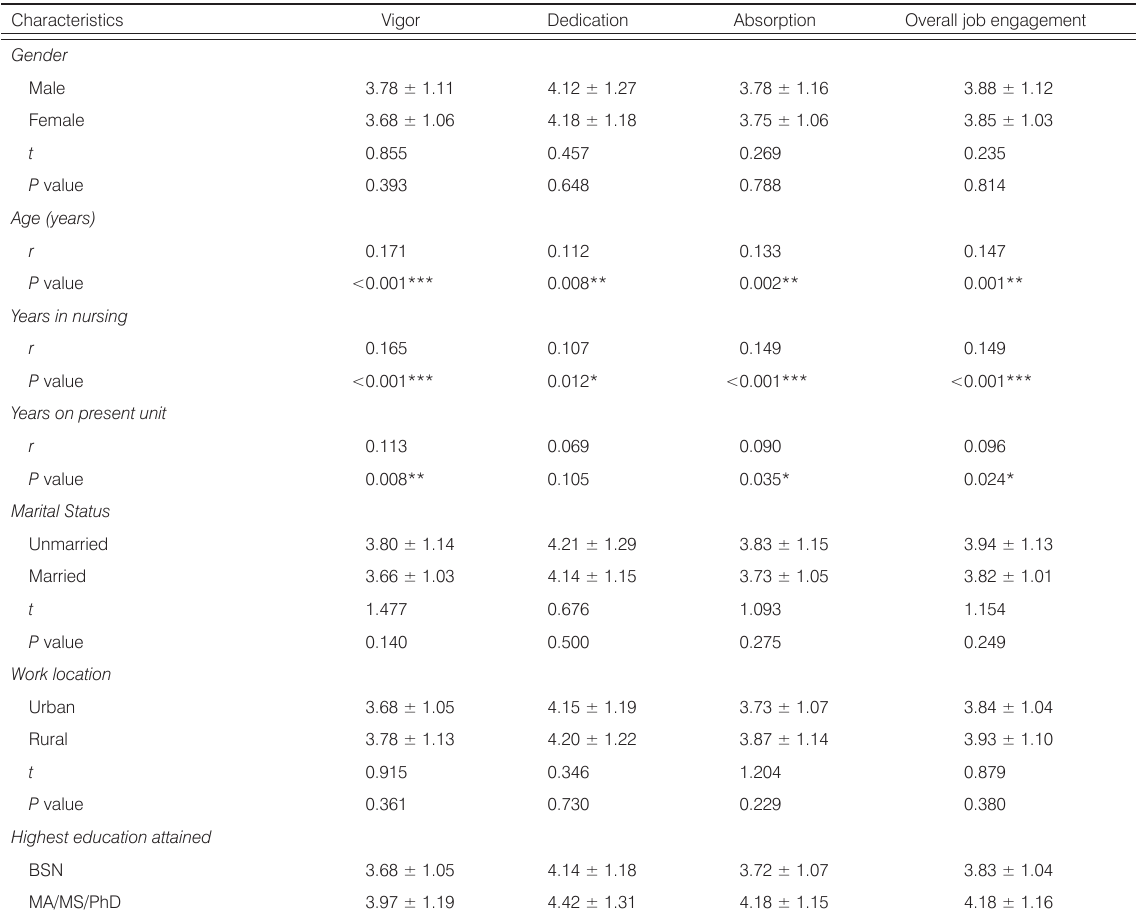
Table 1. Descriptive statistics of nurse work engagement.